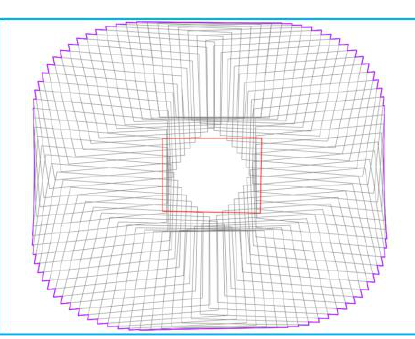
Figure 4. Footprints of the experimental set-up (RefCam – light blue, VertCam – red, ObCam –